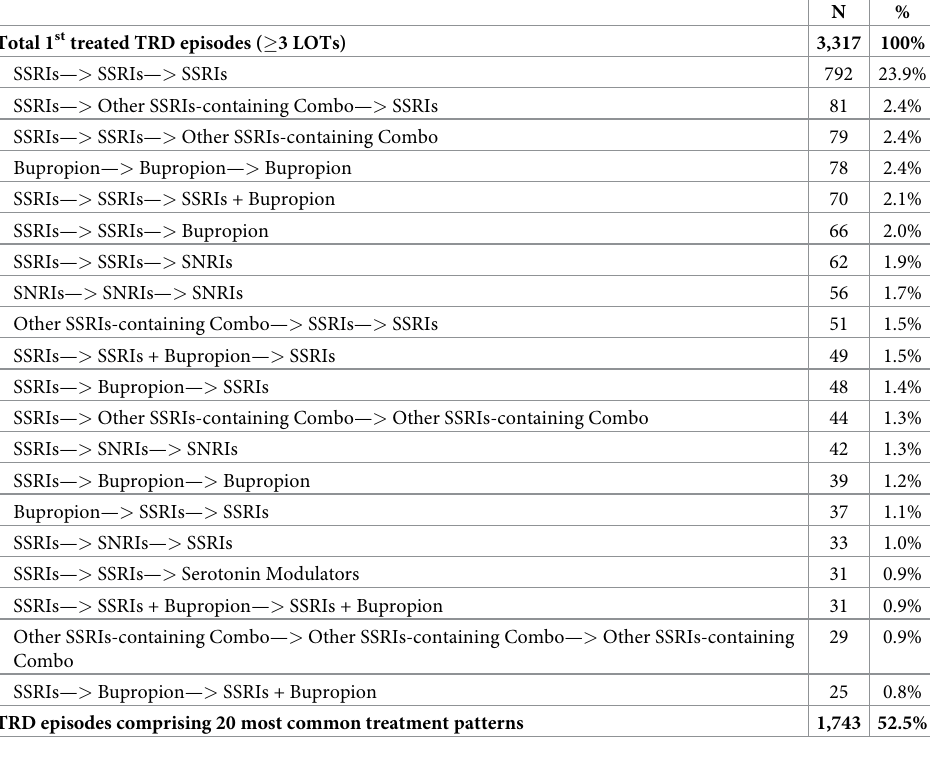
Table 3. Top 20 treatment patterns (LOT 1 to LOT 3) for 1 st treated TRD episodes. Total 1 st treated TRD episodes ( � 3